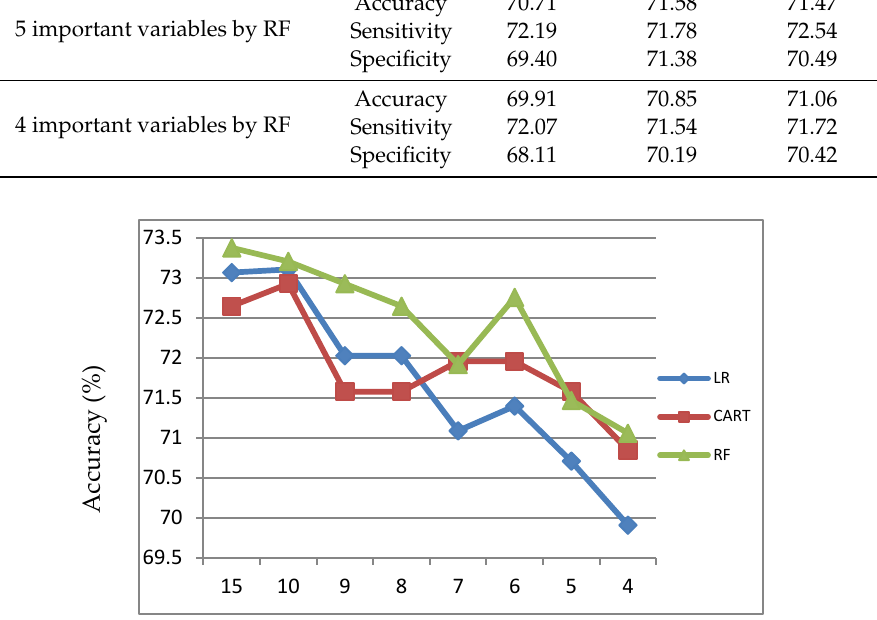
Figure 8. Sensitivity of LR, CART and RF with input of important variables identified by RF. Figure 9. Specificity of LR, CART and RF with input of important variables identified by RF.